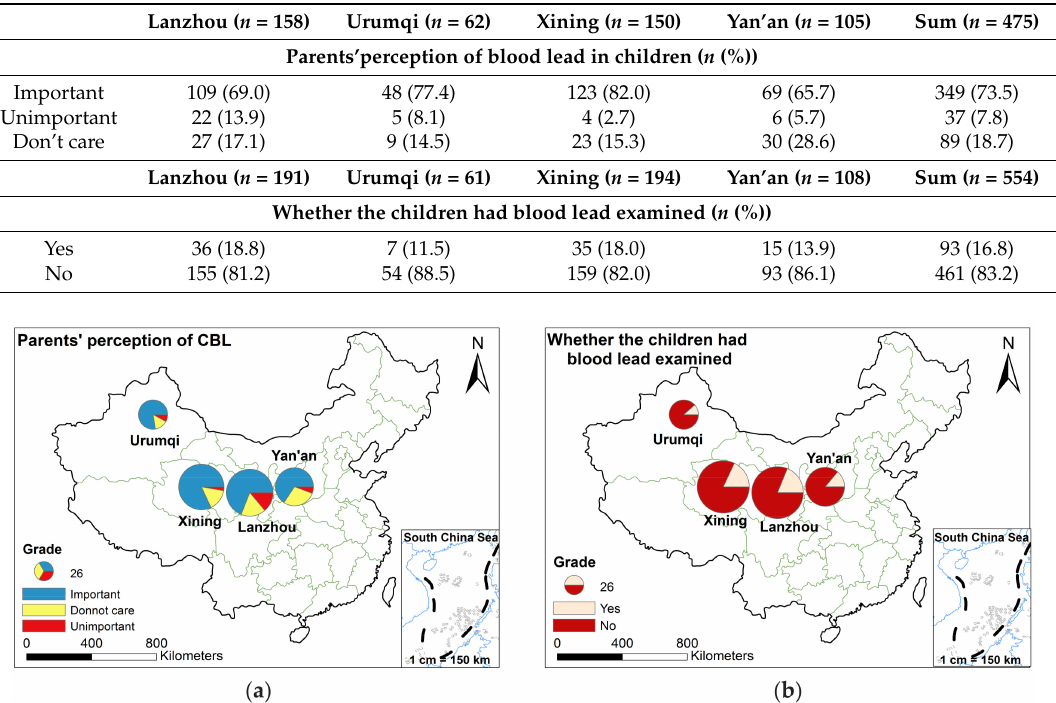
Figure 5. Parents’ perception ( a ) about testing lead in children compared with ( b ) actual blood lead testing in four